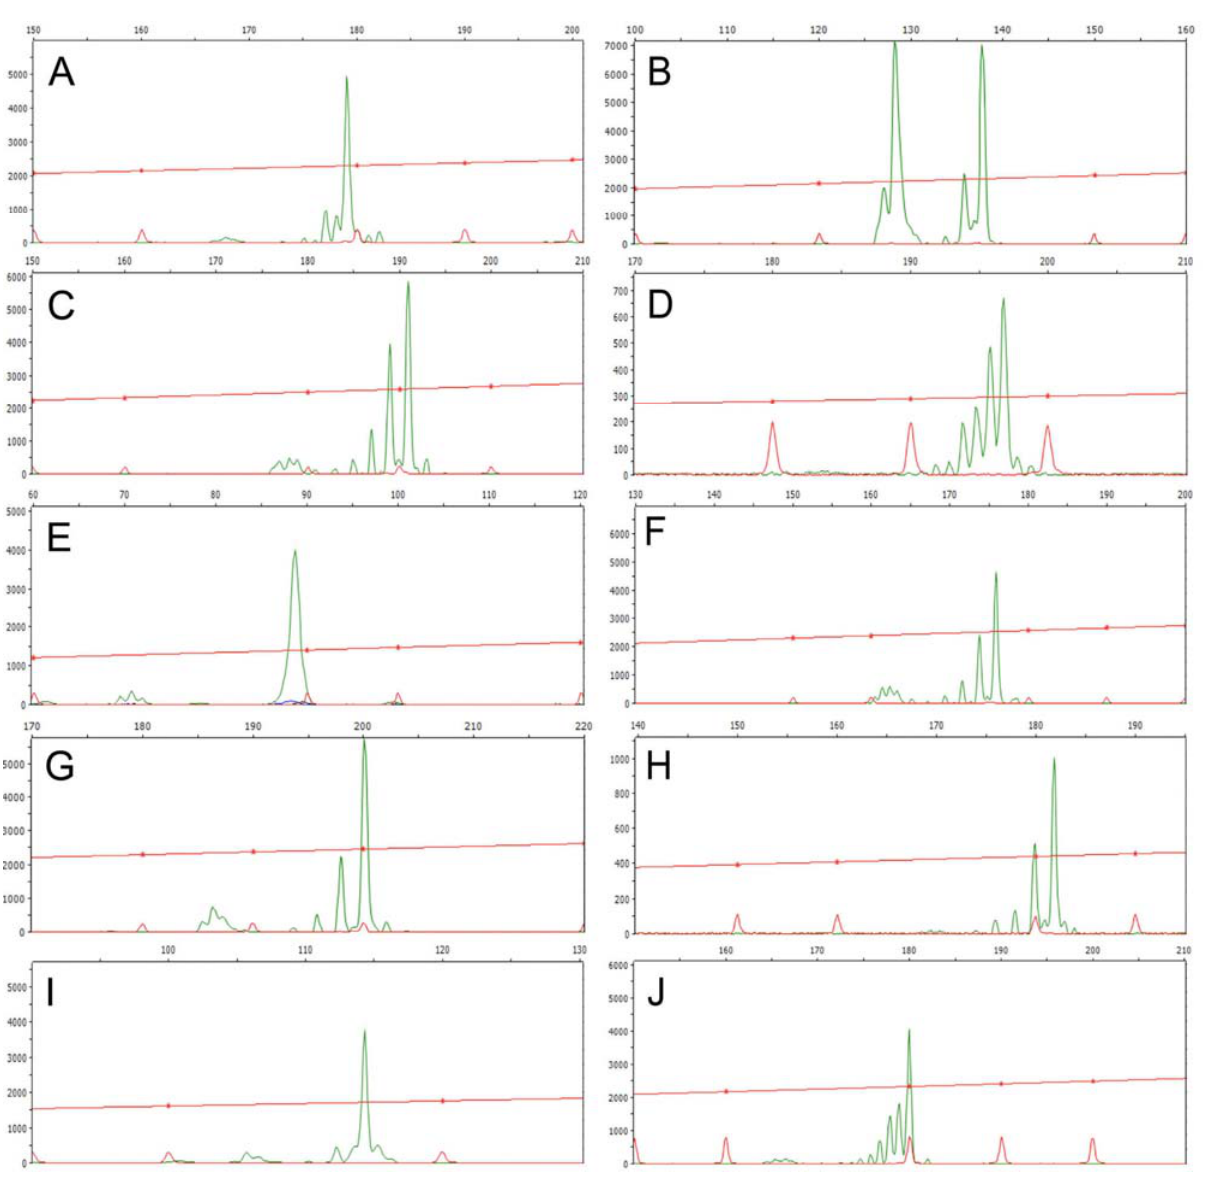
Figure 2. Representative DNA fragment profiles displayed by each of the 10 analyzed microsatellite loci. A , JcSSR1; B , JcSSR2; C , JcSSR3; D , JcSSR4; E , JcSSR5; F , JcSSR6; G , JcSSR7; H , JcSSR8; I , JcSSR9; and J , JcSSR10 (for details on primers, see Table